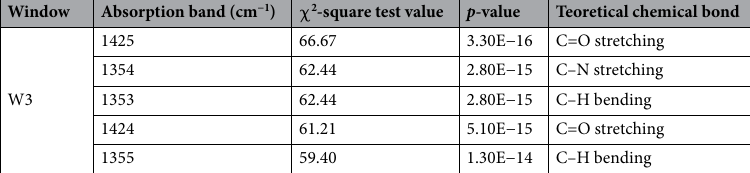
Table 3. Best predictors for H. pylori infection.